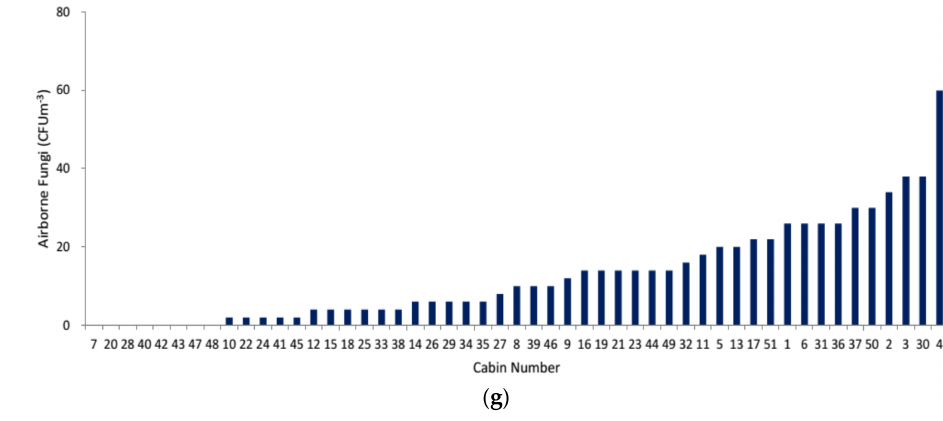
Figure 1. The Indoor Air Quality (IAQ) parameters in the in-cabin microenvironment during driving, particulate matter (PM) 2.5 ( a ); PM 0.3 ( b ); carbon monoxide (CO) ( c ); CO 2 ( d ); total volatile organic compounds (TVOCs) ( e ); Airborne Bacteria ( f ); and, Airborne Fungi ( g ). As there are no IAQ guidelines for PM 0.3 and PM 2.5 , the PM 2.5 levels were compared with the levels recorded in different districts in Hong Kong.